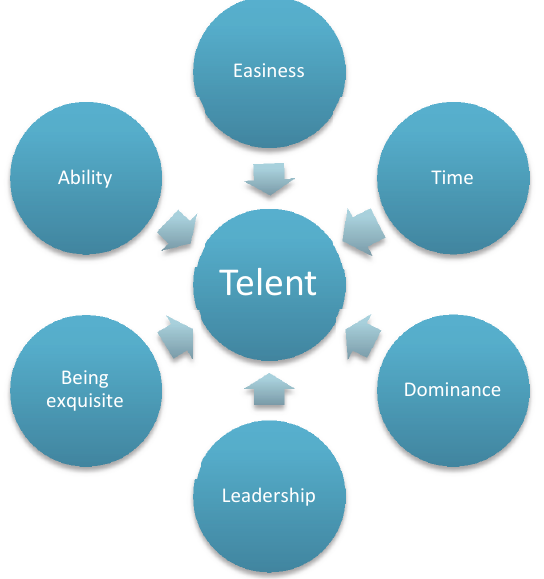
Fig. 1. Fundamental Features of Talent (Do ğ an & Demiral,